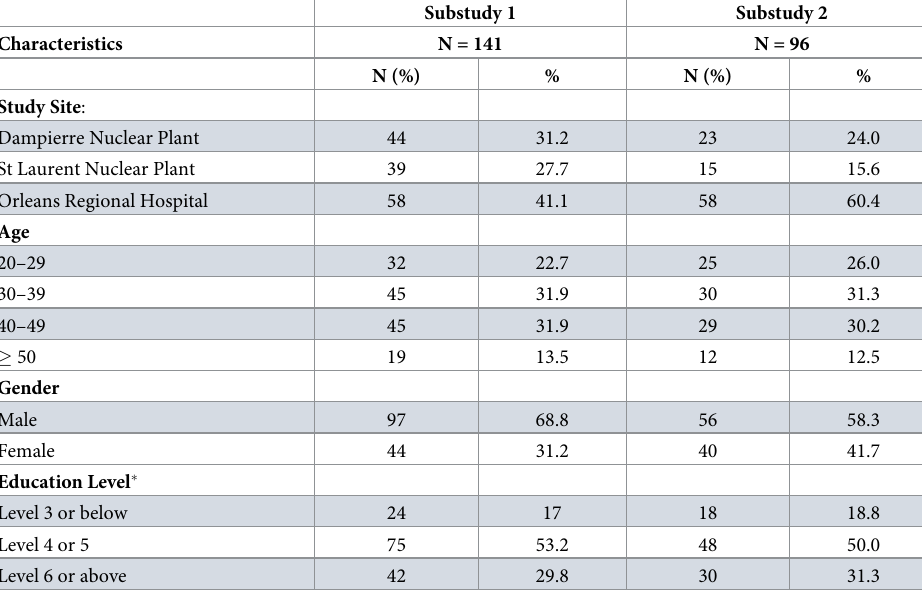
Table 4. Demographic characteristics of the study